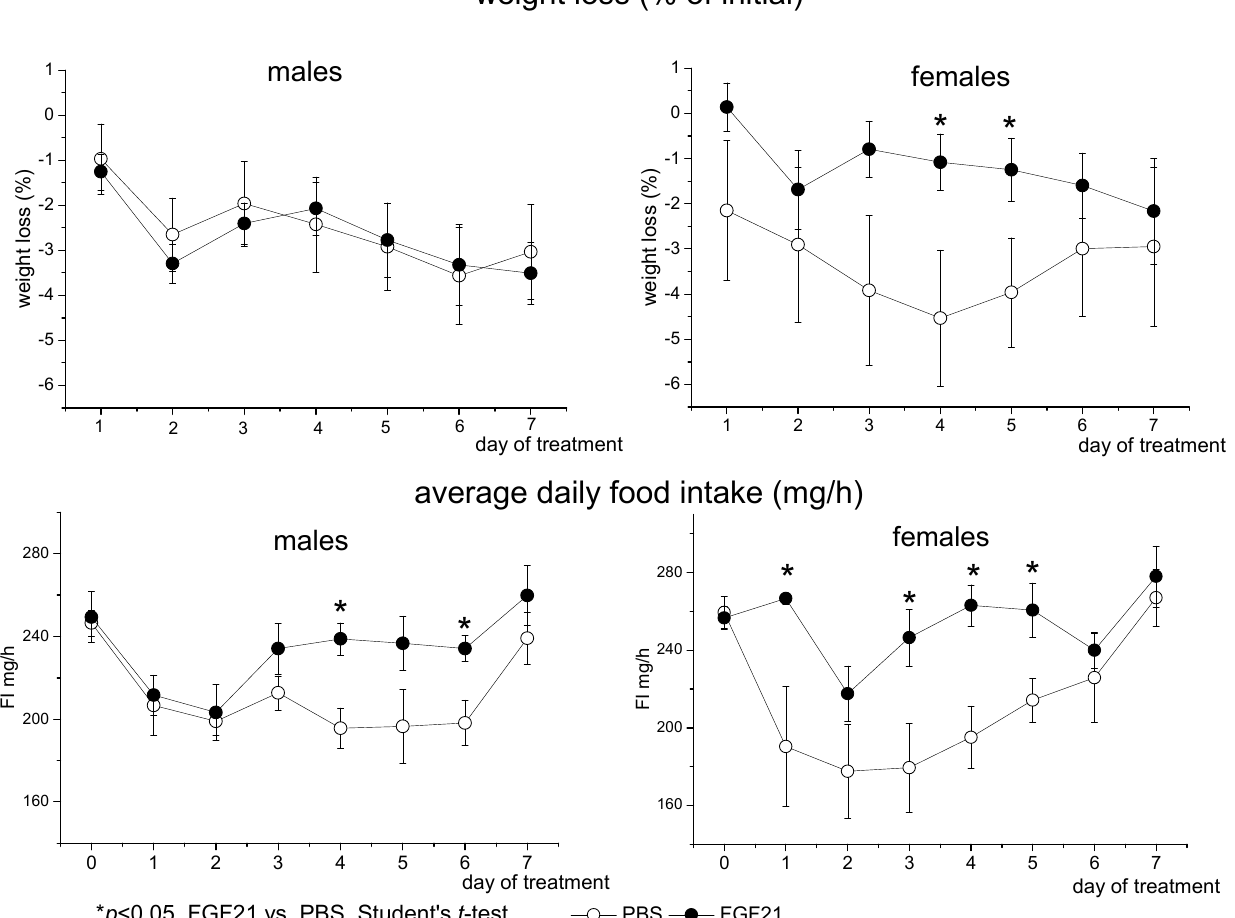
Figure 1. Influence of FGF21 administration on body weight and food intake in obese A y male and female mice. Data are presented as mean ± SE. Mice were administered FGF21 for 7 days from day 0.